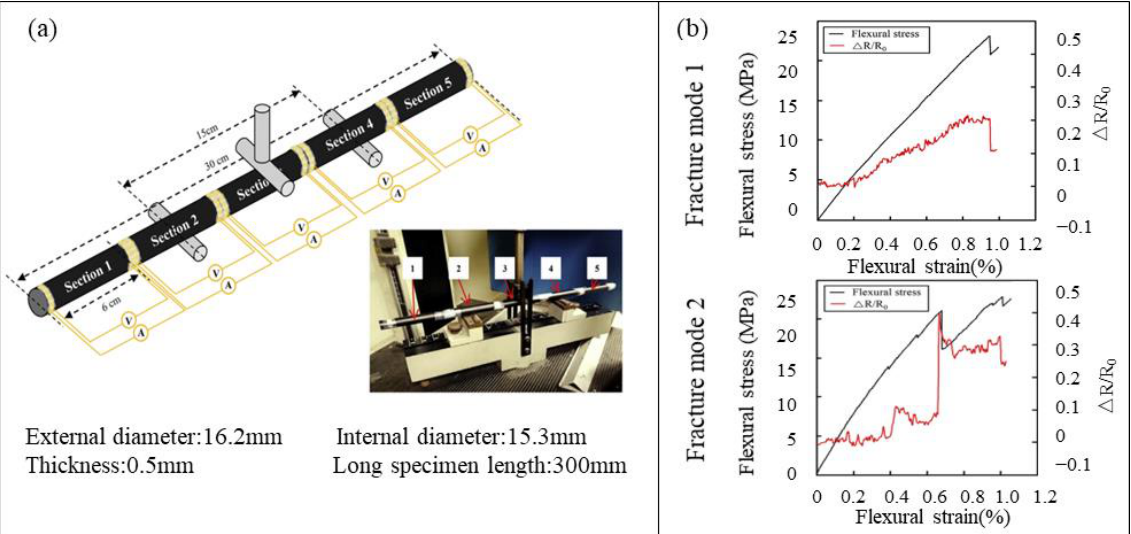
Figure 11. ( a ) Long CFRP cylinder specimen during flexural test; ( b ) resistance variation graph under different fracture mode of CFRP cylinders [159] (Copyright 2016, Elsevier Ltd.).